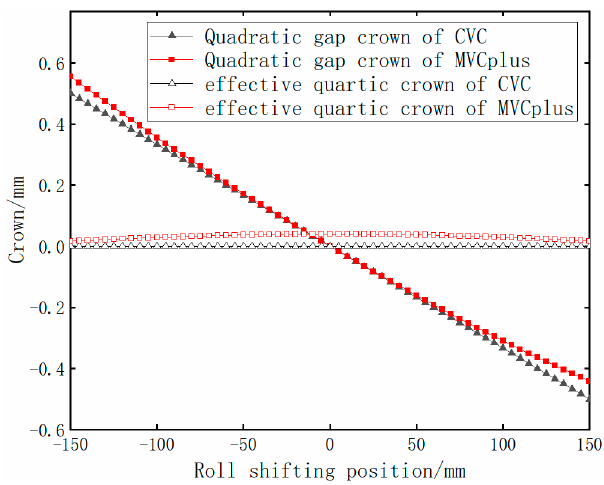
Figure 9. Q uadratic gap crown and effective quartic crown of MVCplus. Figure 9. Quadratic gap crown and effective quartic crown of